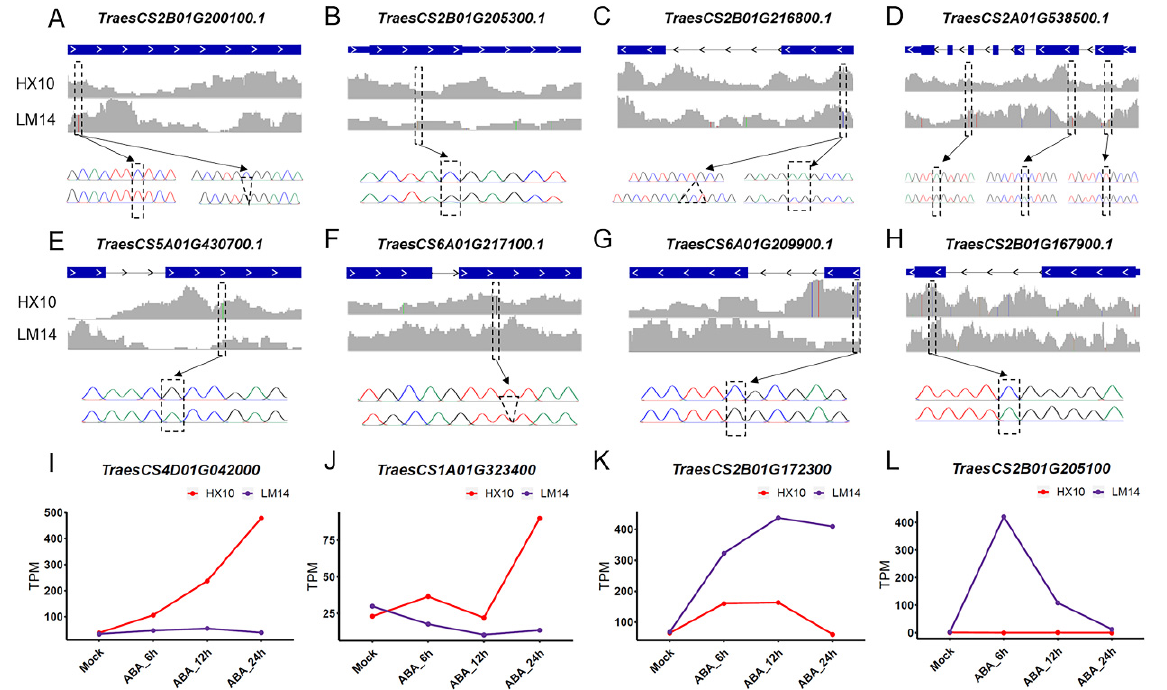
Figure 7. Experimental verification of variations of candidate genes in LM14 and HX10. ( A – H ) The exon structures of candidate genes carrying high- and moderate-effect SNP and InDel variations. The grey peaks show the distribution of re-sequencing reads in the regions. The genomic positions of these variations are indicated by dashed line frames. The results of Sanger sequencing are shown at the bottom of each panel. A, T, G, and C bases are marked in green, red, black, and purple, respectively. ( I – L ) The differential expression patterns of candidate genes are shown.